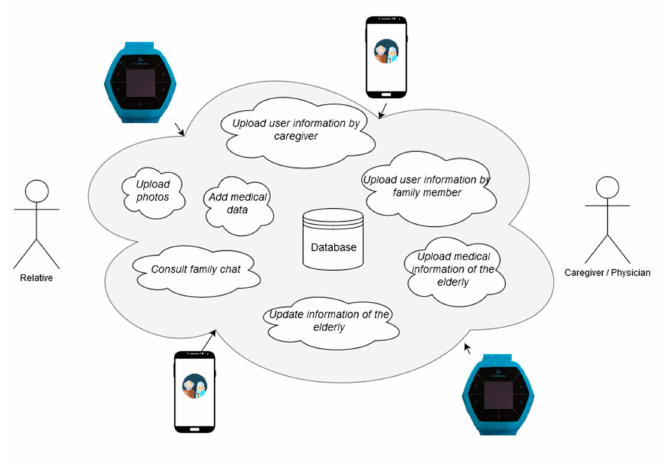
Figure 3. Services available in the cloud and accessible through the middleware. Upload photos : Caregiver-type users can share photos with family-type users. Upload user information by caregiver : This service allows uploading and updating information related to caregiver-type users. Add medical data : The service allows caregiver-type users to create new classifications to personalize the medical data of the elderly at their care. Upload user information by family member : This service allows uploading and updating information related to family-type users. Consult family chat : Caregiver-type users